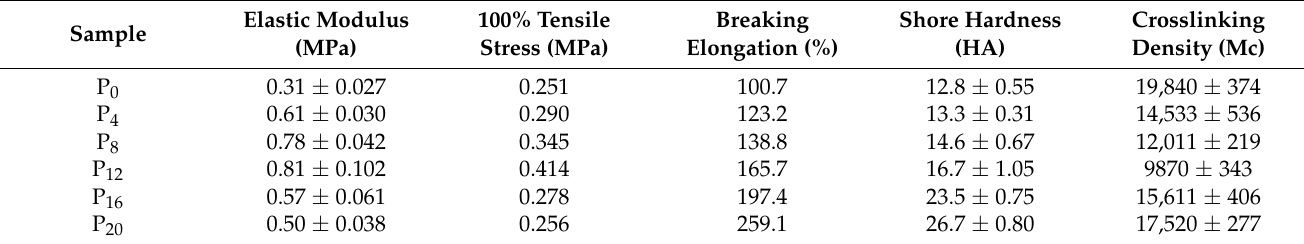
Figure 6. ( a ) The stress-strain curve of the prepared coatings; ( b ) local amplification. Table 2. The mechanical properties of the prepared coatings (±SEM, n = 3).